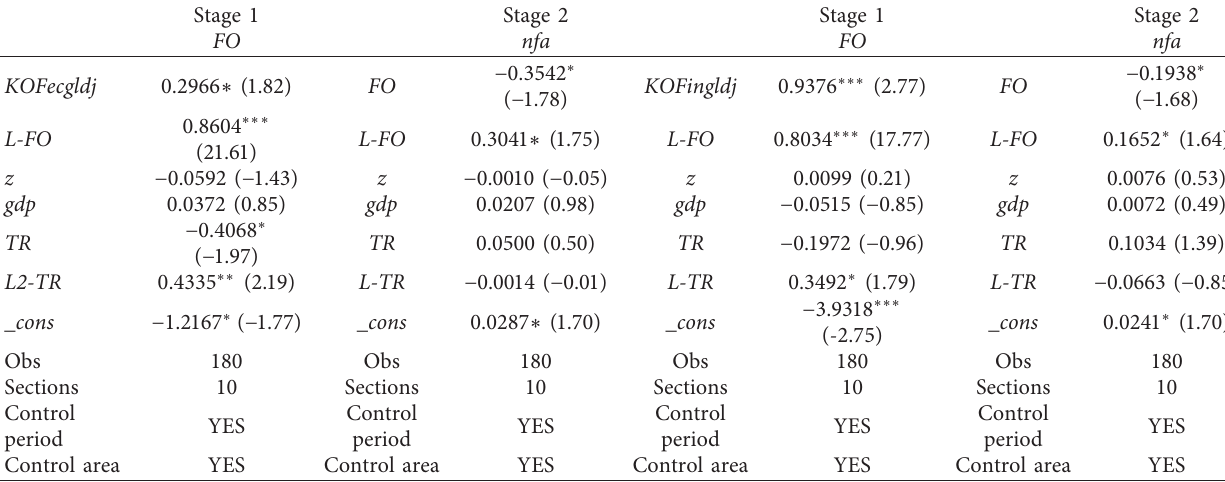
Table 4: Regression results of the instrumental